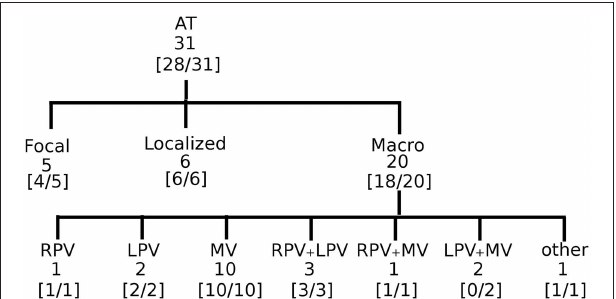
FIGURE 5 | Accuracy of DG mapping in clinical AT. The gold standard was compatible with focal source (5), localized reentry (6), and macro-reentry (20). Macro reentry was categorized in reentry around the right veins (RV), the left veins (LV), mitral valve (MV), around RV + LV, around RV + MV, around LV + MV, and other types of reentry (e.g., in the right atrium). In brackets the accuracy of DG mapping is